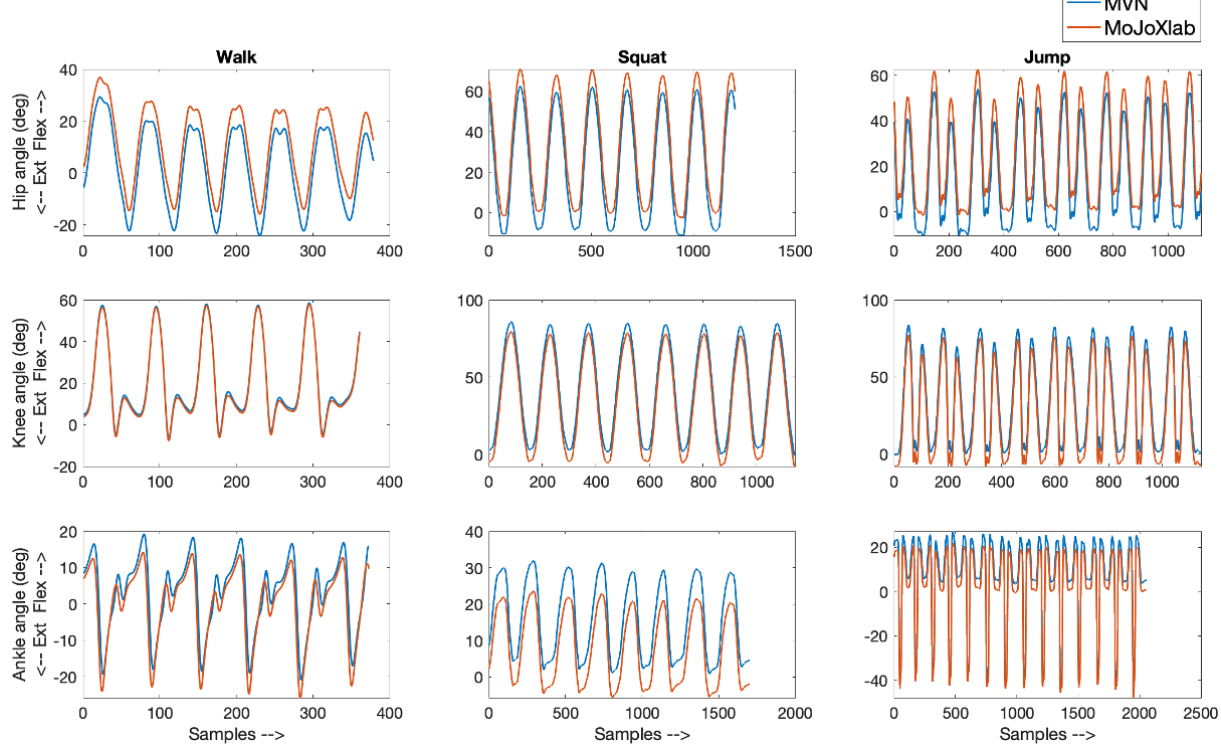
Figure 2. Representative sagittal plane joint angle waveforms from the healthy participant data set. Waveforms for the hip (top row), knee (middle row), and ankle (bottom row) joint angles obtained from MVN Analyze (blue) and our custom software MoJoXlab (orange) for walking (left), squatting (center), and jumping (right) tasks. The y-axis represents joint angles in degrees, and the x-axis represents data samples across the entire